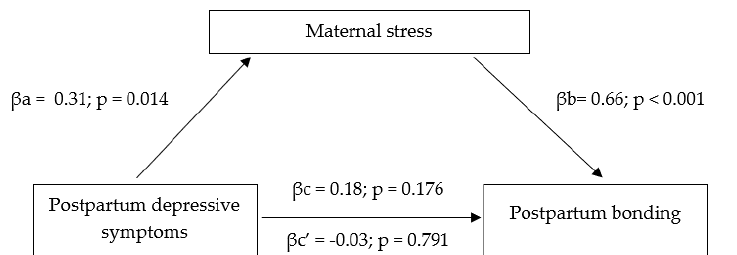
Figure 1. Mediating model of postpartum depressive symptoms on maternal postpartum bonding via maternal stress.